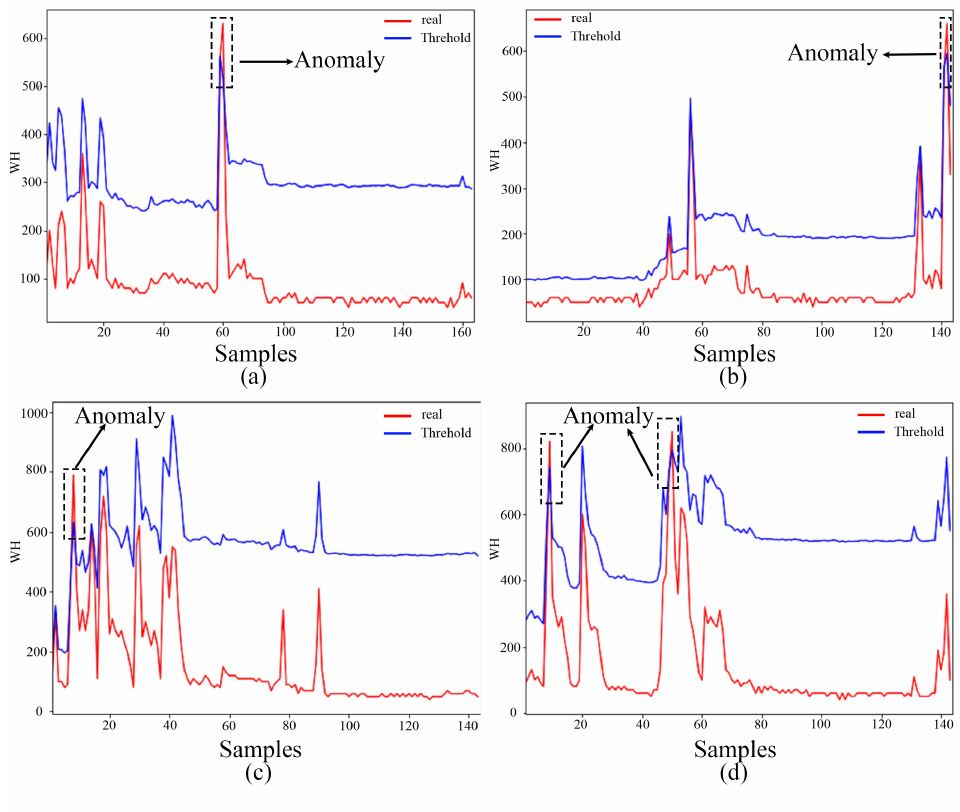
Figure 5. Example of abnormal energy consumption behavior: ( a ) electricity consumption on 7 May; ( b ) electricity consumption on 12 May; ( c ) electricity consumption on 21 May; ( d ) electricity consumption on 26